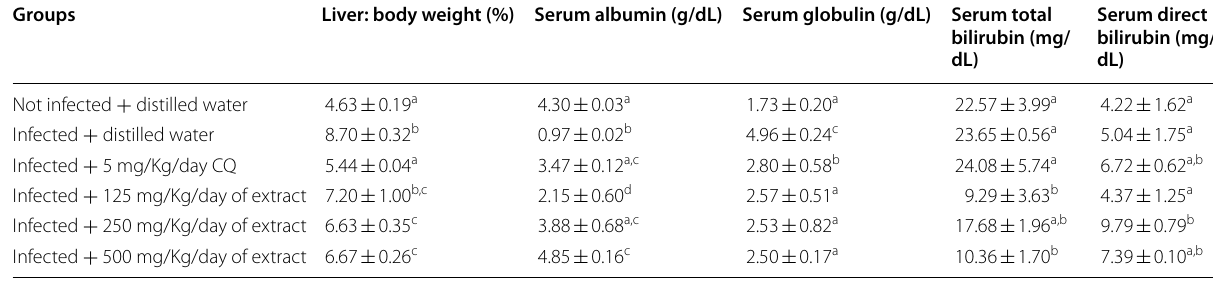
Values are mean S.E.M ( n 8) ± = CQ chloroquine Values with different alphabet superscripts in the same column are significantly different ( P < 0.05)